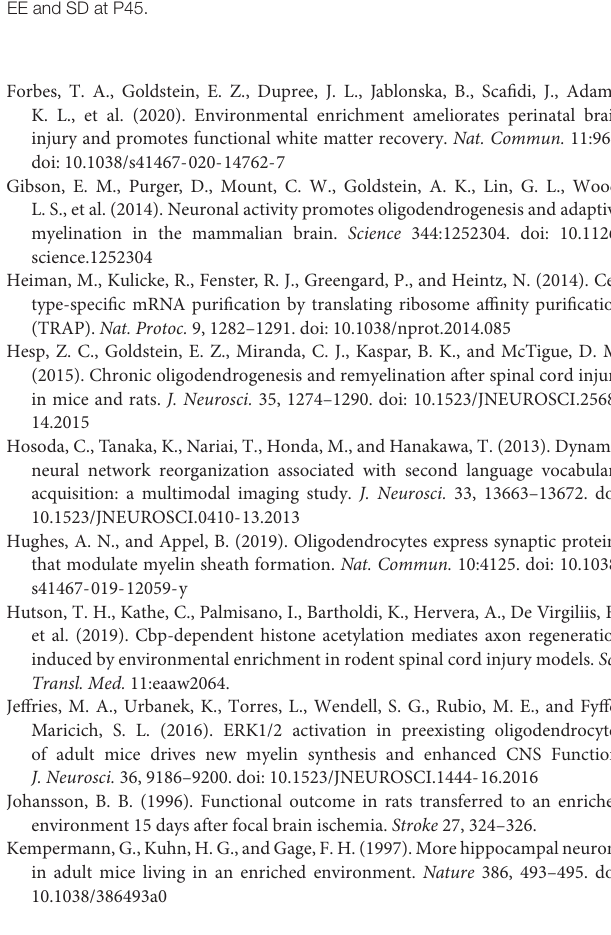
Supplementary Table 1 | Top 50 OL RNAs from P22 subcortical WM. Supplementary Table 2 | Top 50 OL RNAs from P30 subcortical WM. Supplementary Table 3 | Top 50 OL RNAs from P45 subcortical WM. Supplementary Table 4 | Differentially expressed genes between EE and SD at P22. Supplementary Table 5 | Differentially expressed genes between EE and SD at P30. Supplementary Table 6 | Differentially expressed genes between EE and SD at